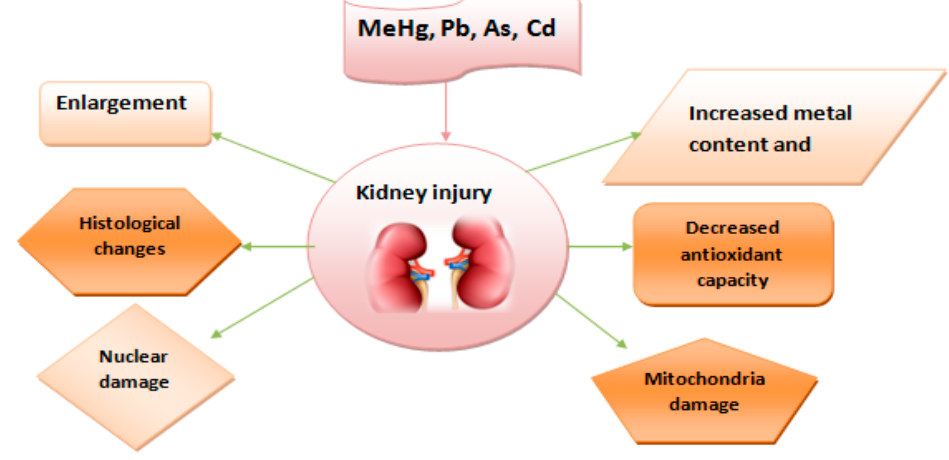
Figure 5. A conceptual framework of metal mixture effects on the kidney.